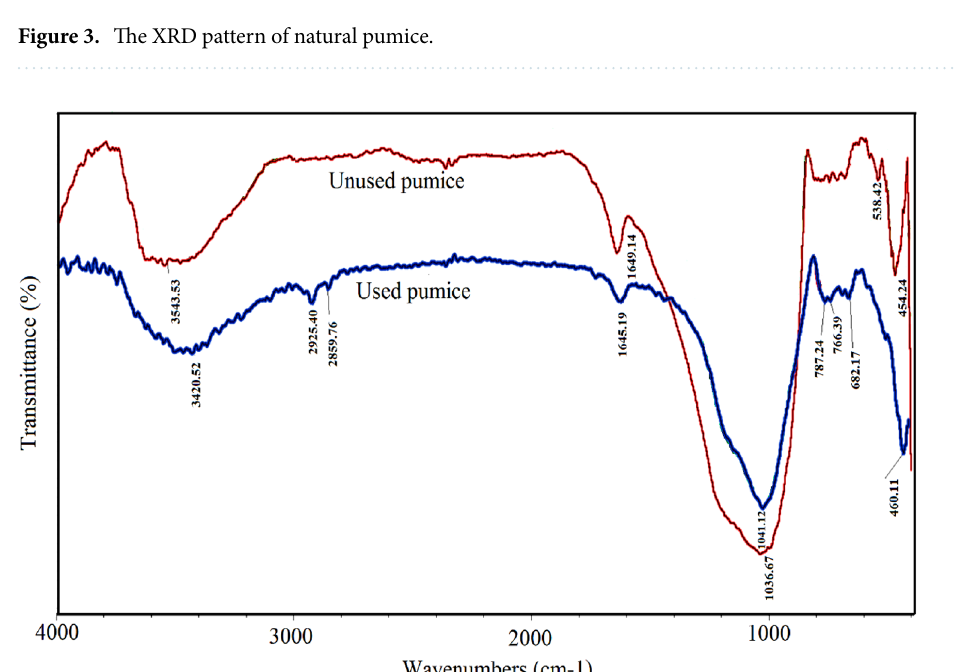
Figure 4. FTIR spectrum for used and unused